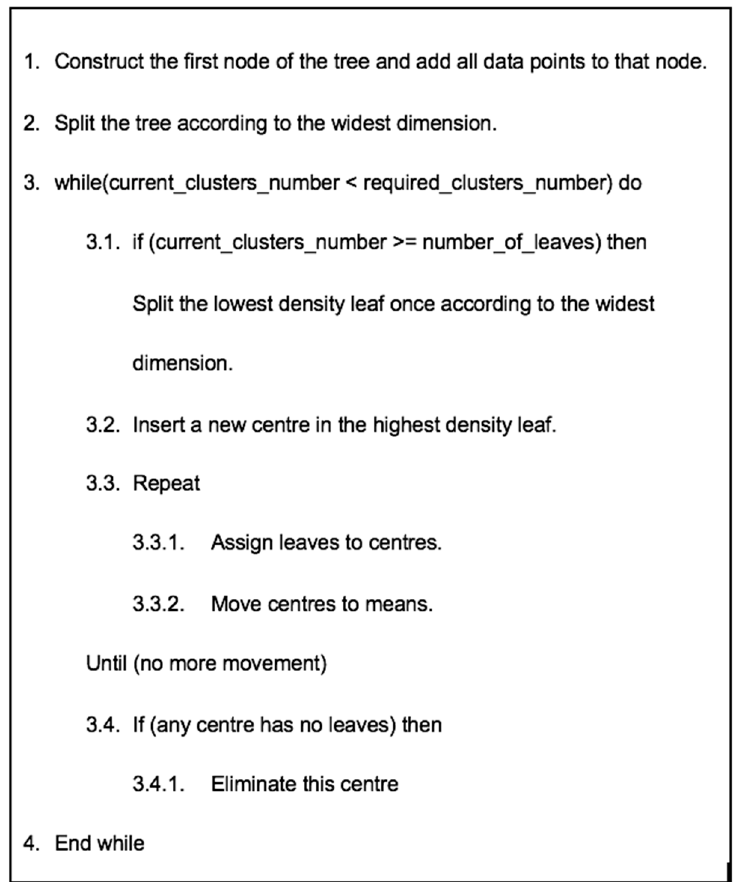
Figure 3. The pseudo-code of the proposed algorithm.